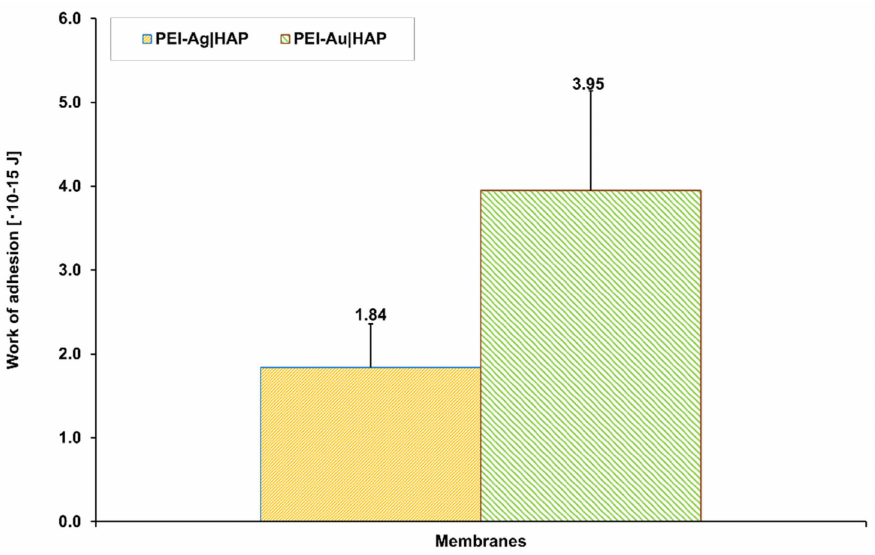
Figure 10. The work of adhesion between the HAP and PEI-Ag or HAP and PEI-Au